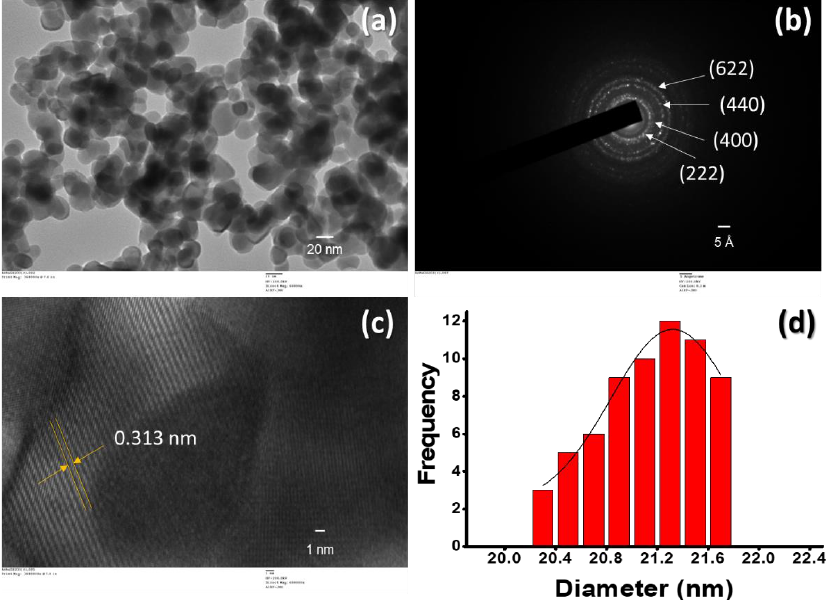
Figure 2. HR-TEM images of ( a ) Gd 2 O 3 NPs; ( b ) SAED pattern of Gd 2 O 3 NPs; ( c ) HR TEM images of Gd 2 O 3 NPs; and ( d ) NPs size